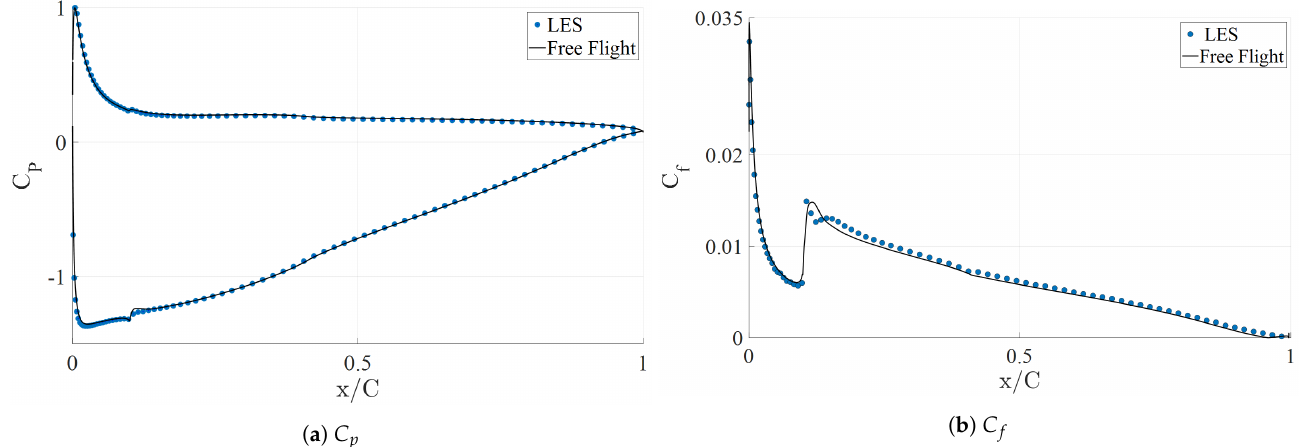
Figure 4. LES vs. RANS: Chord-wise distribution comparisons at AOA = 5 ◦ in free-flight conditions. The well-resolved LES statistics were obtained from Ref. [30].